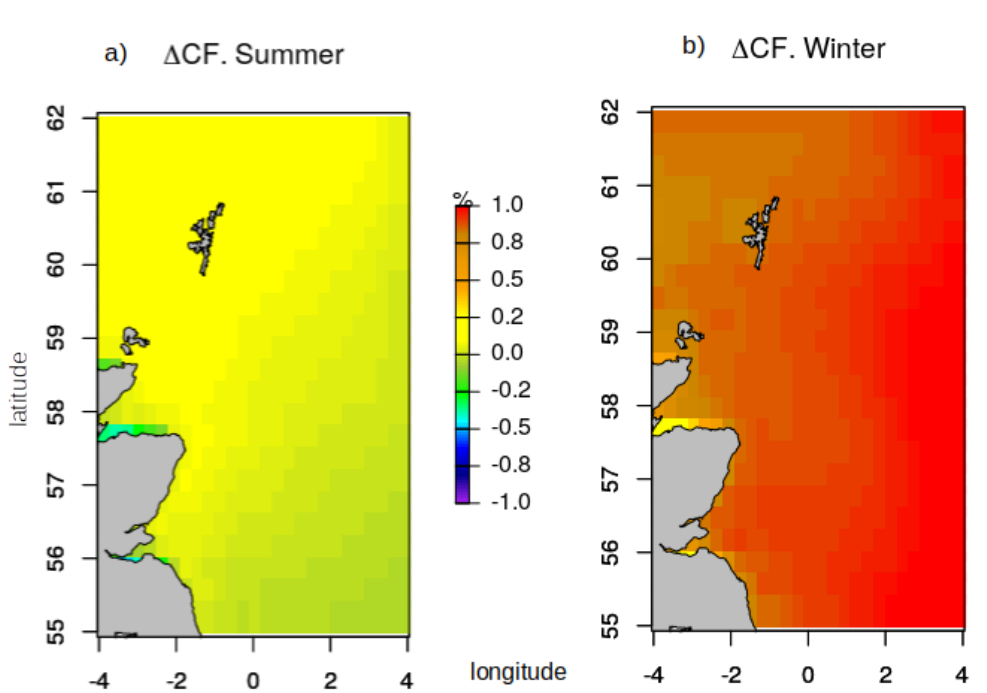
Figure 4. Changes in the capacity factor ( ∆ CF ) in percentage terms in the study area: ( a ) summer; ( b ) winter.